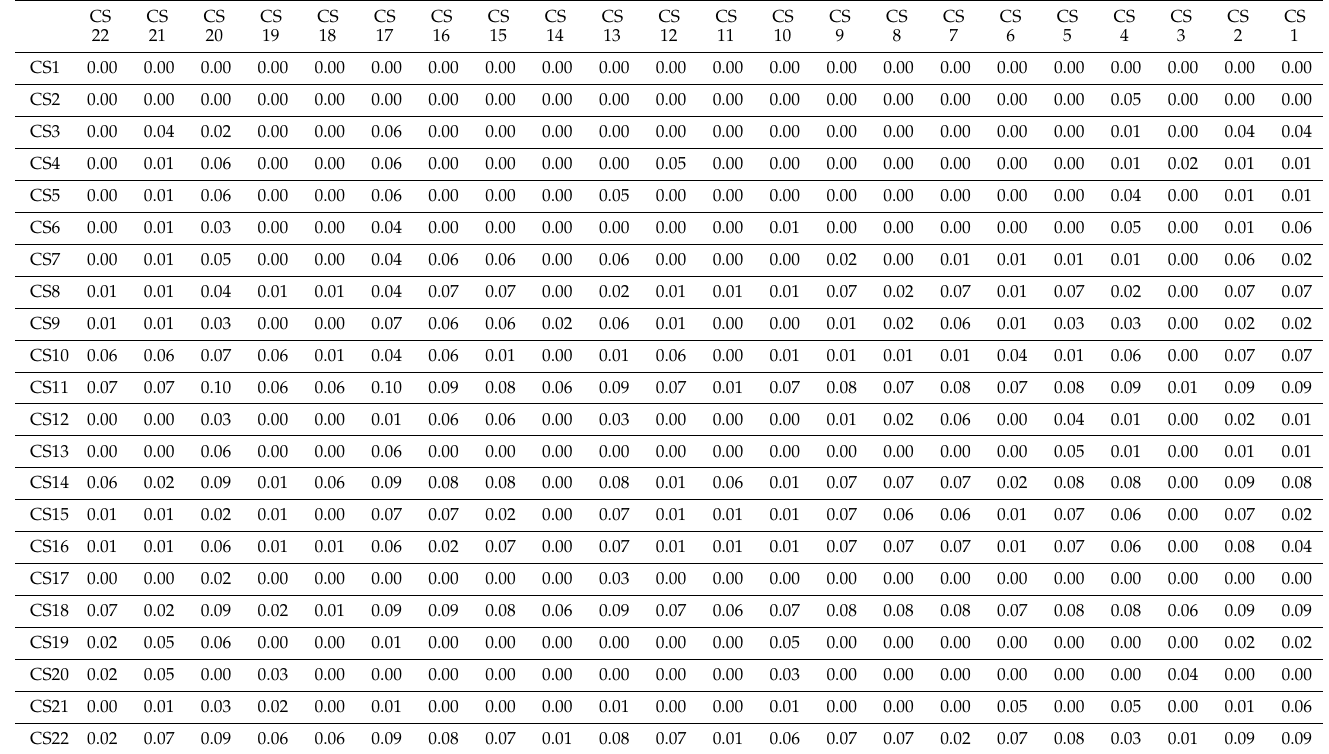
Table A5. Total effect